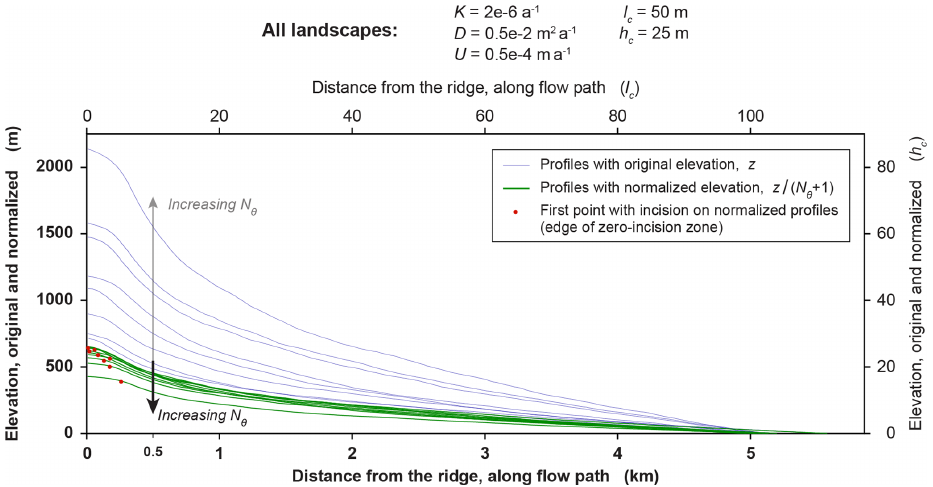
Figure 9. Steepening of profiles as the incision-threshold number N θ increases. Blue profiles show elevation z versus distance from the ridge (along the flow path) for the longest flow paths in each of the nine landscapes of Sect. 3.2. These flow paths are marked with blue lines on the maps in Figs. 4–8. All profiles have roughly equal horizontal lengths of ∼ 5km, or ∼ 100 l c (see lengths in Table 5). As N θ increases, the total reliefs of profiles (i.e., their elevations at the ridge) increase, and, thus, their slopes become steeper (see reliefs and mean slopes in Table 5). On each profile, a red dot shows the edge of the zero-incision zone, defined here as the first point along the profile with first point with incision, and a blue circle shows the first-order valley head, defined as the first point with nonnegative curvature ( ∇ 2 z ≥ 0). We do not show a red dot for N θ = 0, for which zero-incision zones do not exist. As N θ increases, the red dots and the blue circles tend to move away from the ridge, indicating that the zero-incision zones become wider, and the drainage density decreases as N θ increases. Note that the edges of the zero-incision zones are more sensitive to N θ than the valley heads are. Thus, as N θ increases, the red dots and blue circles converge, becoming indistinguishable for N θ = 4.